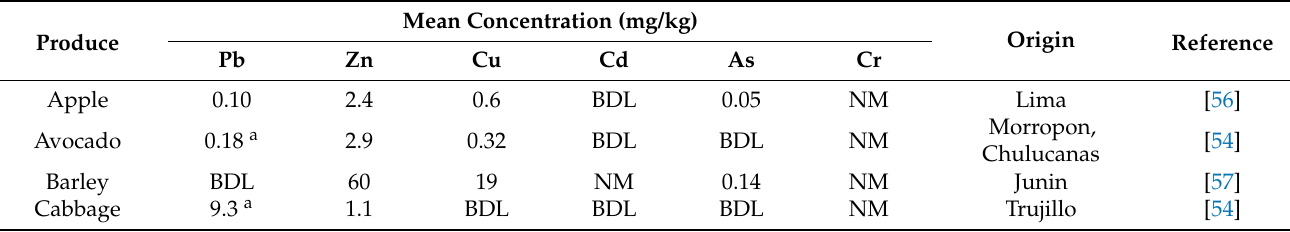
Table 5. Heavy-metal contamination in produce grown in